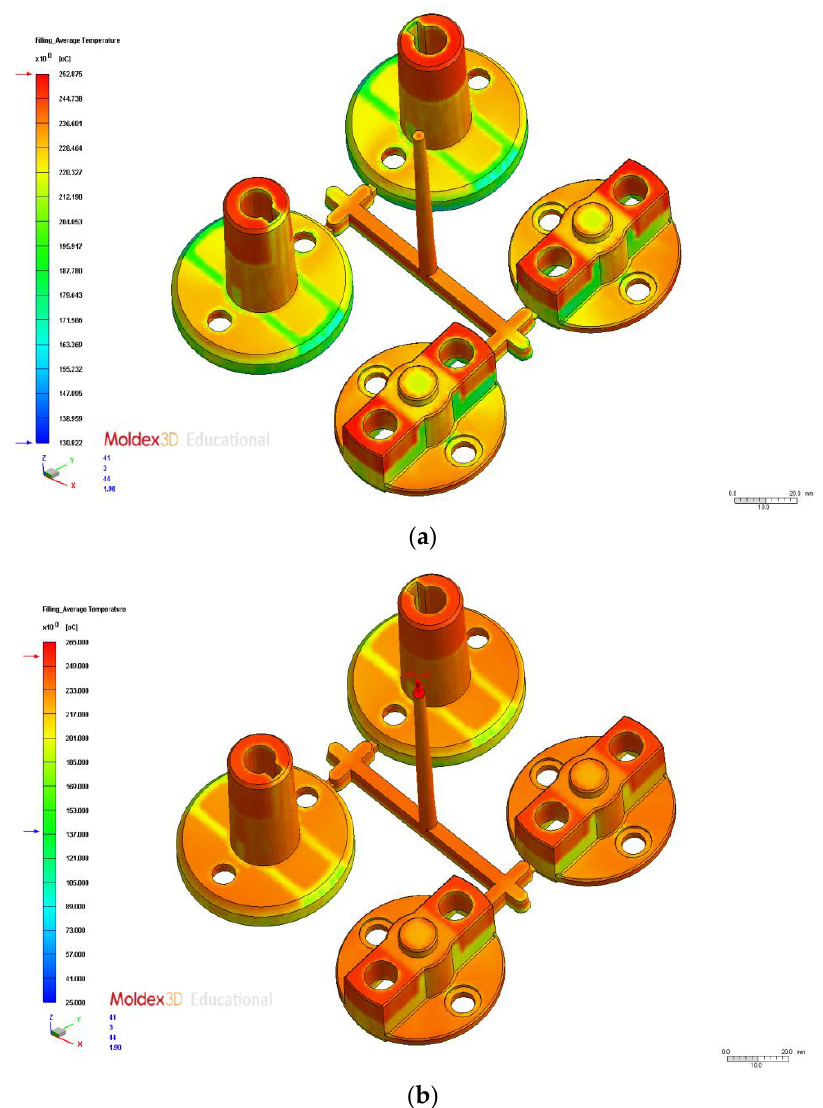
Figure 8. Average Temperature Distribution. ( a ) Original process. ( b )